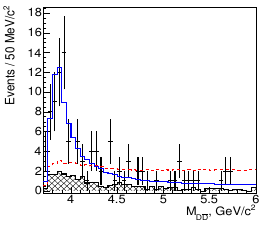
Figure 8. Projection of the signal fit result in the default model onto M D ¯ D [38]. The hatched histograms are the background, the blue solid line is the fit with a new X ∗ (3860) resonance ( J PC = 0 ++ ), and the red dashed line is the fit with non-resonant amplitude only. It is noted that the fitted results are consistent with the pure S-wave production of the X ∗